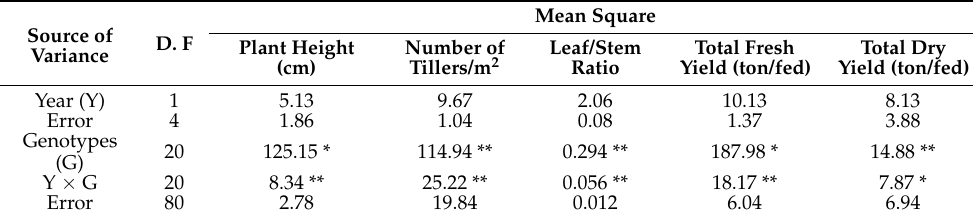
Table 4. Combined analysis of yield components and forage yield of twenty-one alfalfa genotypes across the two